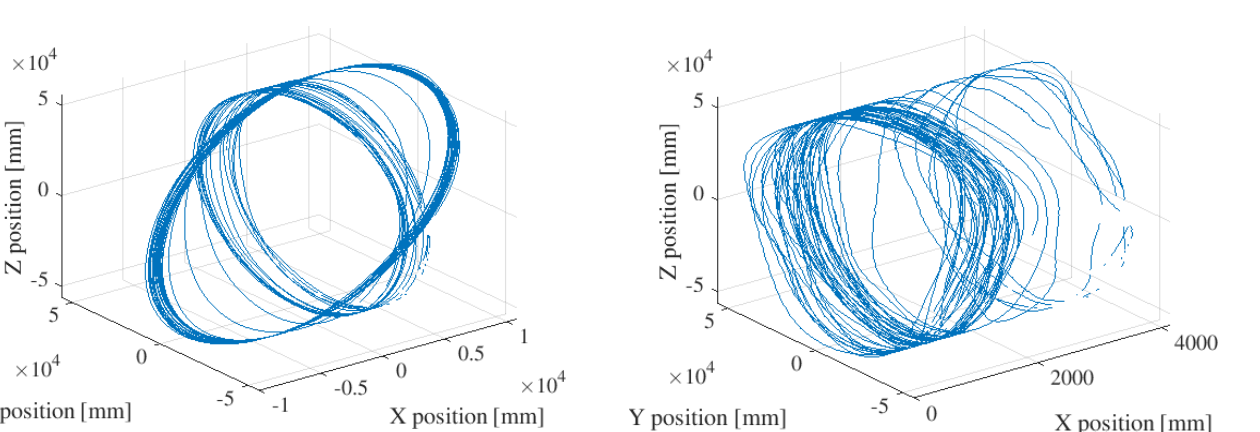
Figure 11. Track of one measurement point of DIC aligned to the rotor